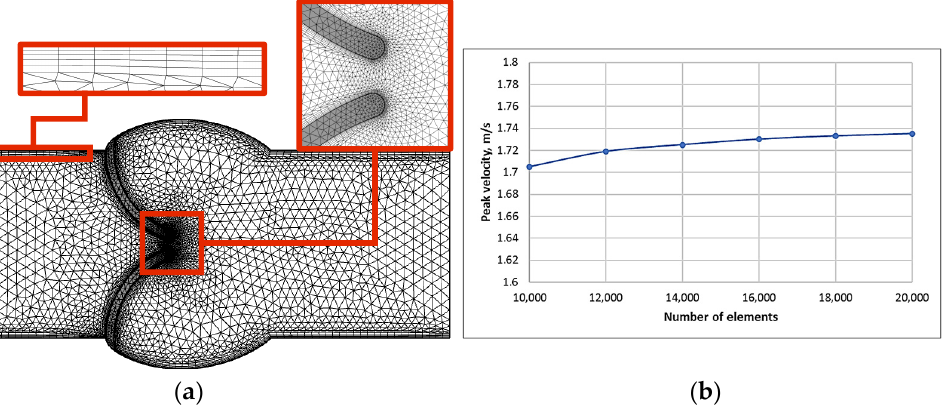
Figure 2. ( a ) Mesh view and ( b ) the peak velocity’s dependence on the number of mesh elements.